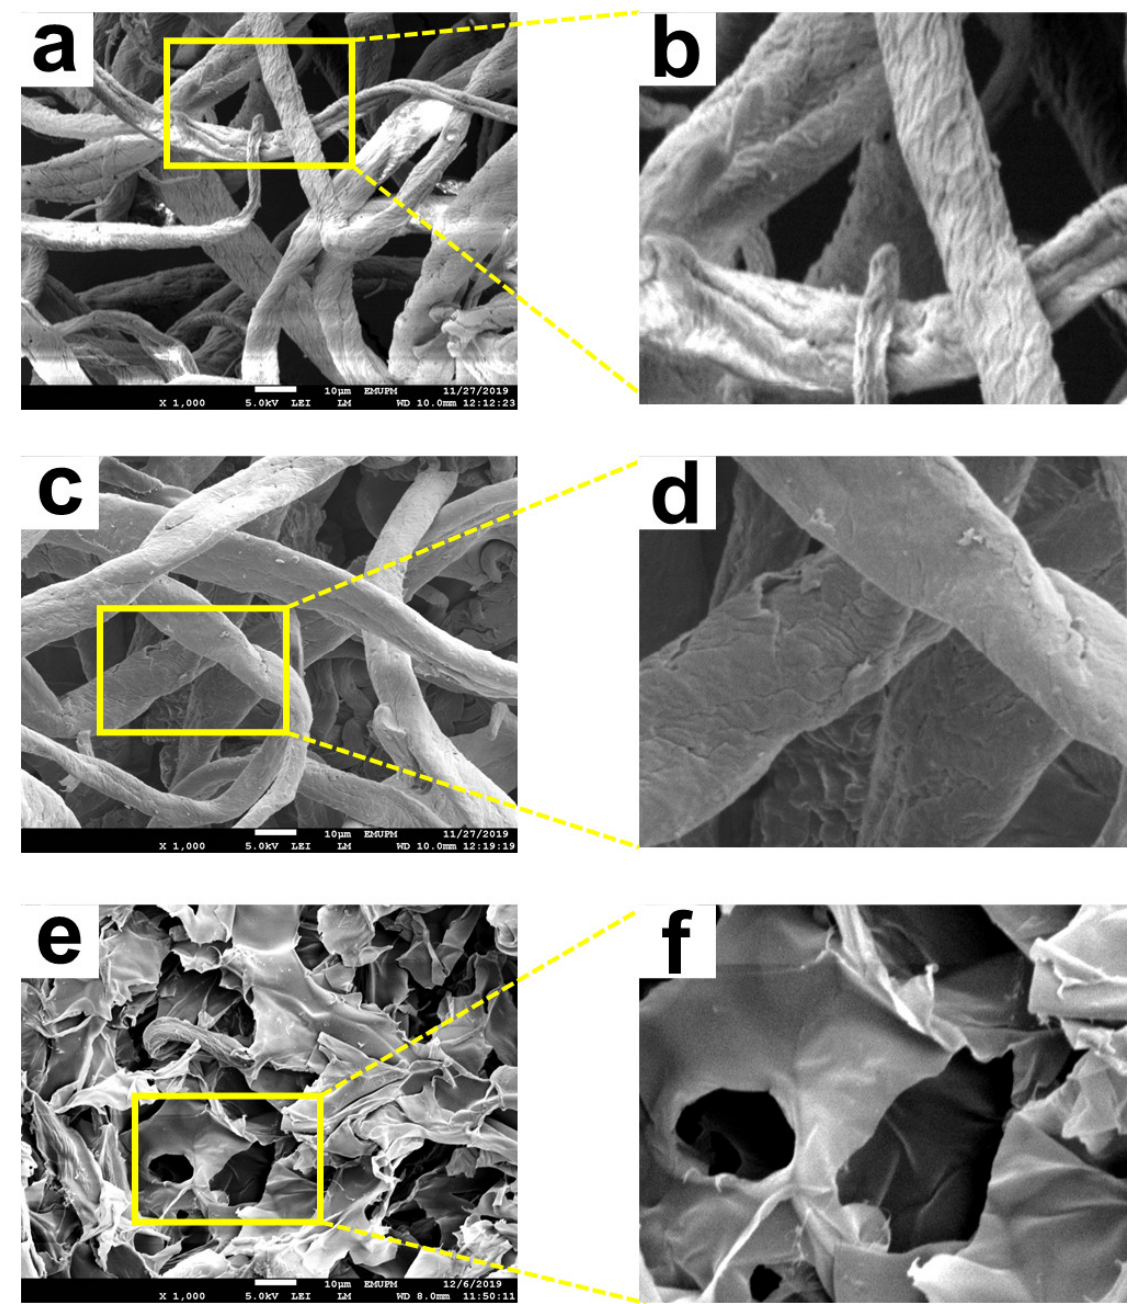
Figure 12. FESEM micrographs of OPEFB cellulose ( a , b ), CMC ( c , d ), and CMC hydrogel ( e , f ) at 1000×.